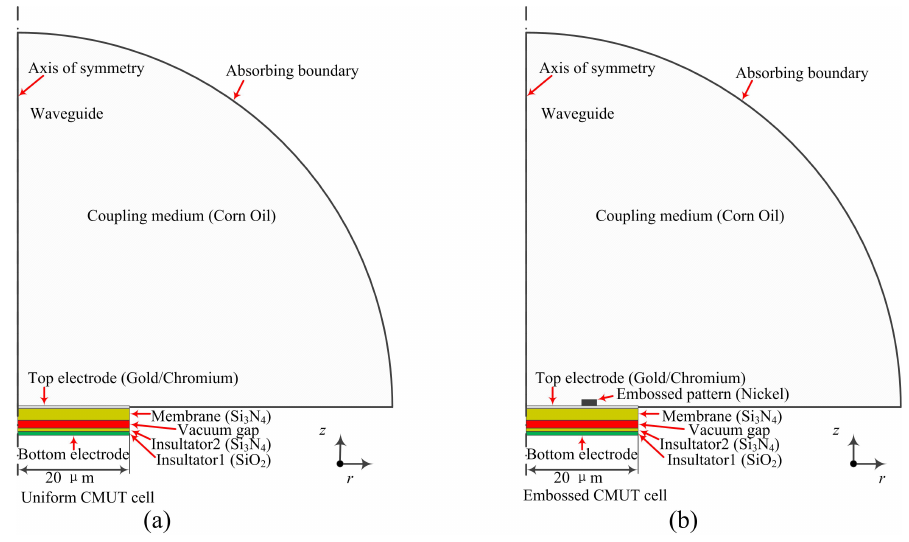
Figure 2. Two-dimensional axisymmetric finite element analysis (FEA) models in COMSOL (Not drawn in scale). ( a ) A uniform CMUT cell; ( b ) An embossed CMUT cell.